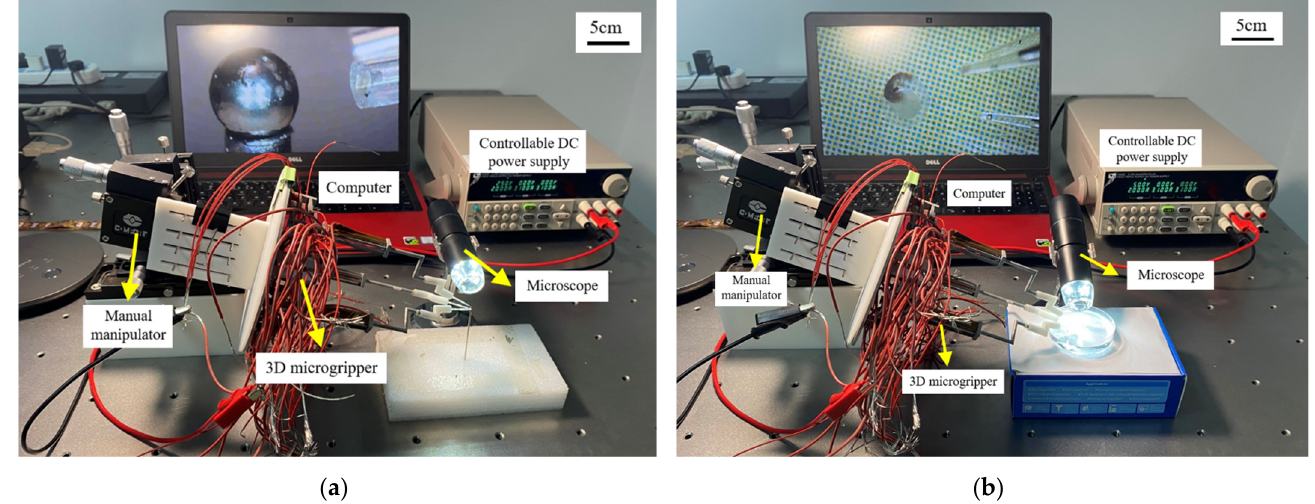
Figure 14. Experimental setup for manipulating ( a ) a micro ball and ( b ) the zebrafish embryo.